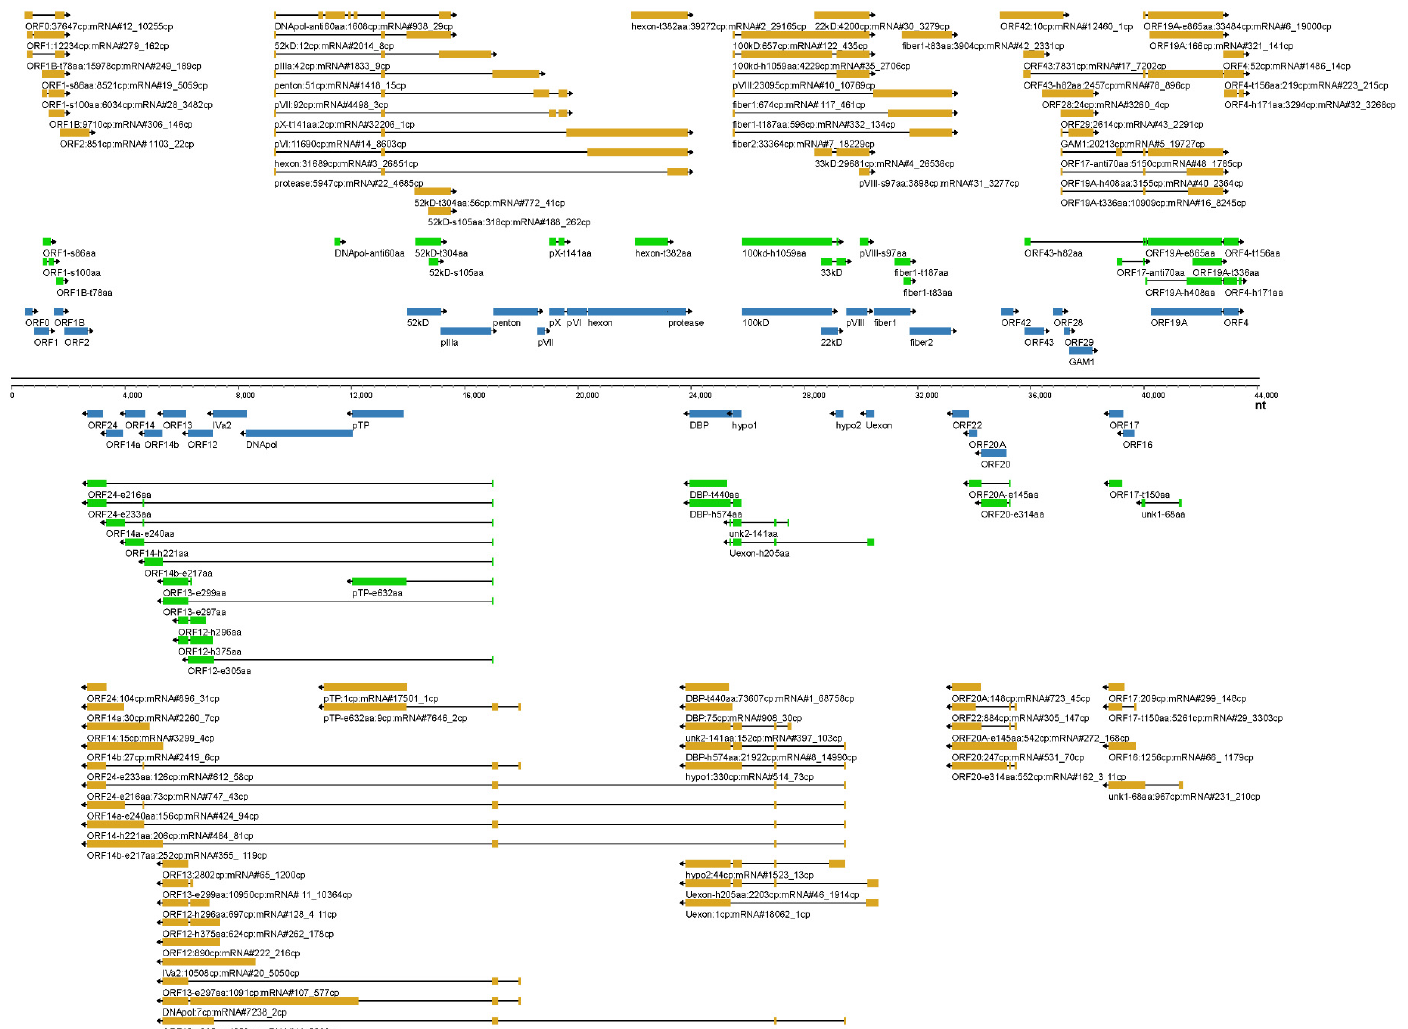
Figure 10. The main transcripts for the 81 selected FAdV-41 ORFs. The most abundant transcripts for each one of the 81 selected FAdV-41 ORFs except pX were annotated. The transcript for pX was not detected because the extremely high GC content in some regions hampered the amplification of full-length cDNA by PCR.